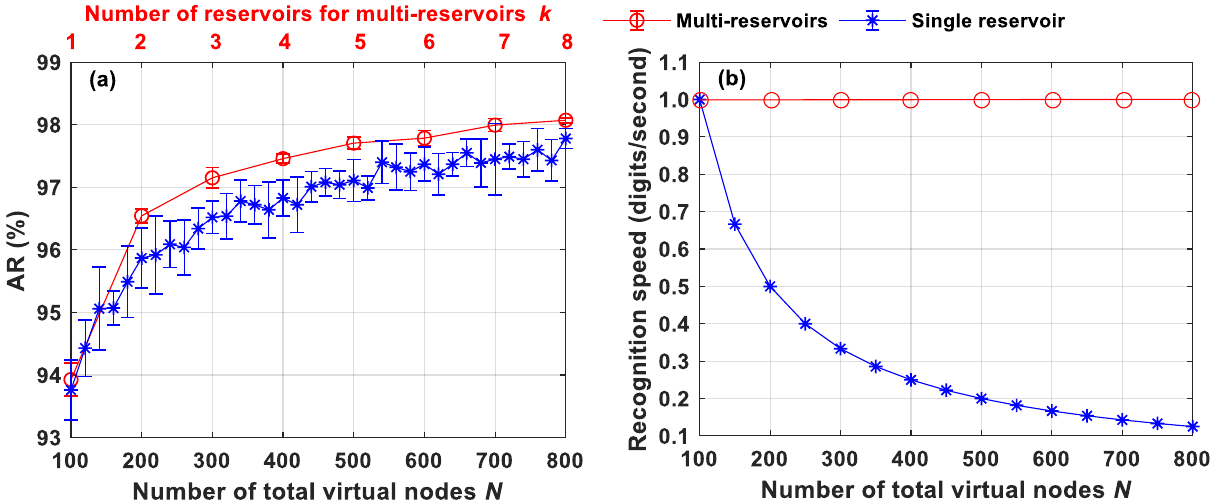
Figure 6. ( a ) AR as a function of the number of total virtual nodes N . ( b ) Recognition speed as a function of N . The red line is for k -reservoirs with each reservoir possessing 100 nodes ( k × 100 = N ), and the blue line is for a single reservoir with N virtual nodes.